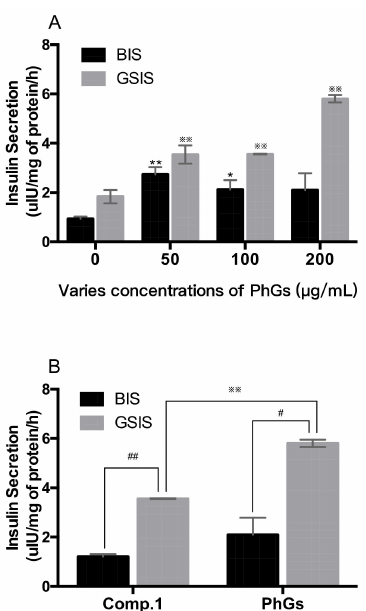
Figure 4. E ff ect of compound 1 and PhGs on glucose-stimulated insulin secretion from INS-1 cells. ( A ) Various concentrations of PhGs were described; the black columns show the BIS groups, the grey columns show the GSIS groups; ( B ) A 200 µ g / mL dose between PhGs and compound 1 was portrayed. * p < 0.05, ** p < 0.01 compared with cells incubated with 2.8 mM glucose only (BIS groups); ※※ p < 0.01 compared with cells incubated with 16.7 mM glucose only (GSIS groups); # p < 0.05, ## p < 0.01 compared with cells between BIS groups and GSIS